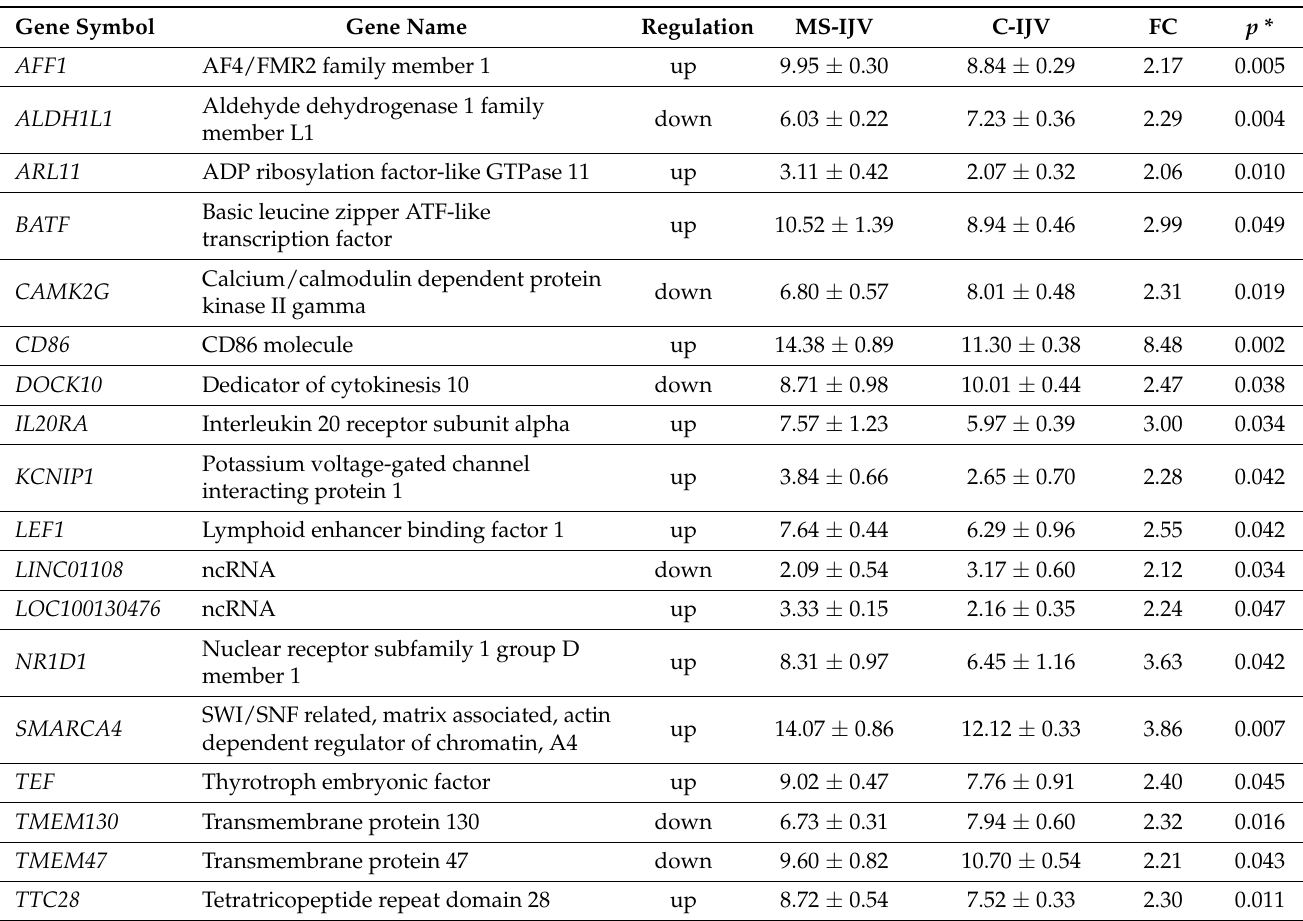
Table 1. MS-GWAS genes differentially expressed between MS and control IJV